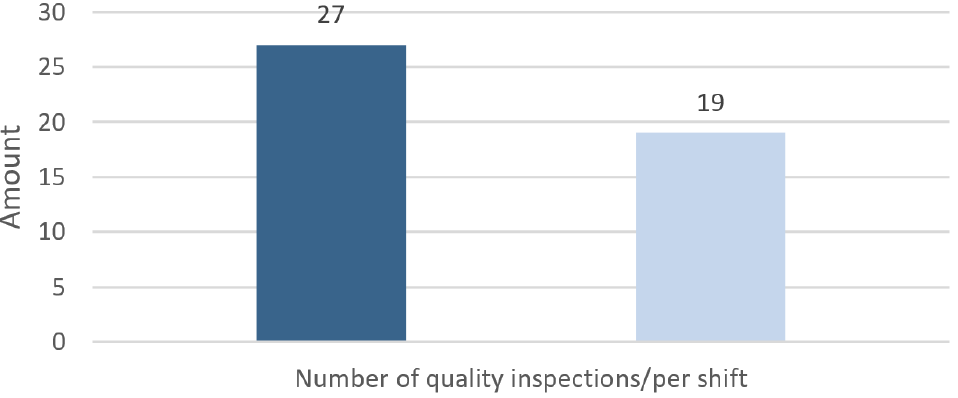
Figure 17. Comparison of the number of strip surface quality inspections over a 12-h shift before and after the introduction of the two-step quality control.